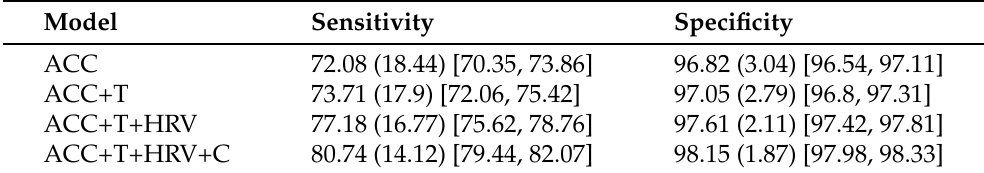
Figure 6. Epoch by epoch sensitivity for sleep and wake and the four models compared in this paper. Whiskers are computed as 1.5 times the interquartile range. Table 2. Epoch by epoch sensitivity for wake and the four models compared in this